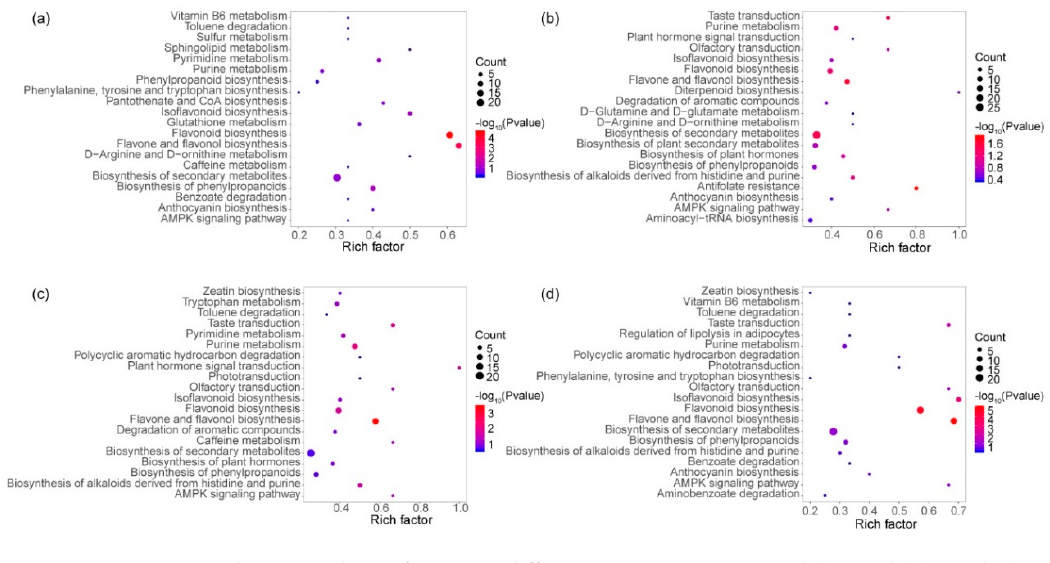
Figure 5. KEGG enrichment analysis of DEMs at different stages. DEMs in 105d ( a ), 115d ( b ), 125d ( c ), and 135d ( d ) were mapped into the KEGG database, and the top 20 enriched metabolic pathways in different stages were showed in the bubble diagram. The color of the bubble represented the − log 10 ( p -value) of the corresponding pathway, the closer to red color the bubble was, the more significant the corresponding pathway performed. The size of the bubble represented the number of metabolites which were enriched in the corresponding pathway.